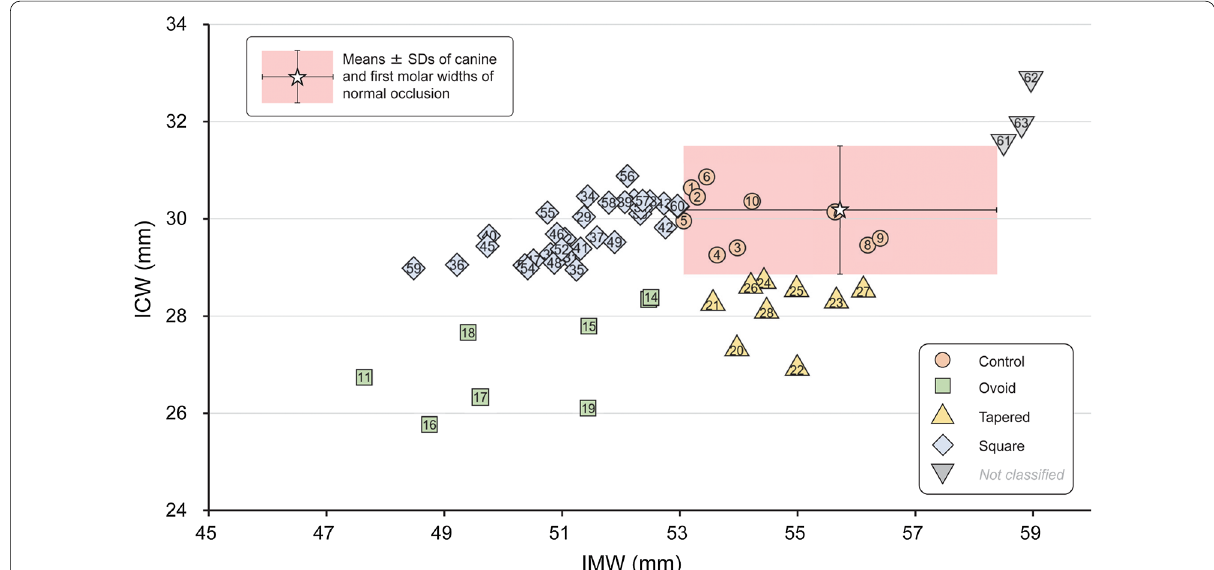
Fig. 7 Distribution of 63 types of preformed archwire widths (intercanine width (ICW) and intermolar width (IMW)) with archwire ID numbers and group classifications, and comparison of means and standard deviations (SDs) of the dental arch widths for normal occlusion